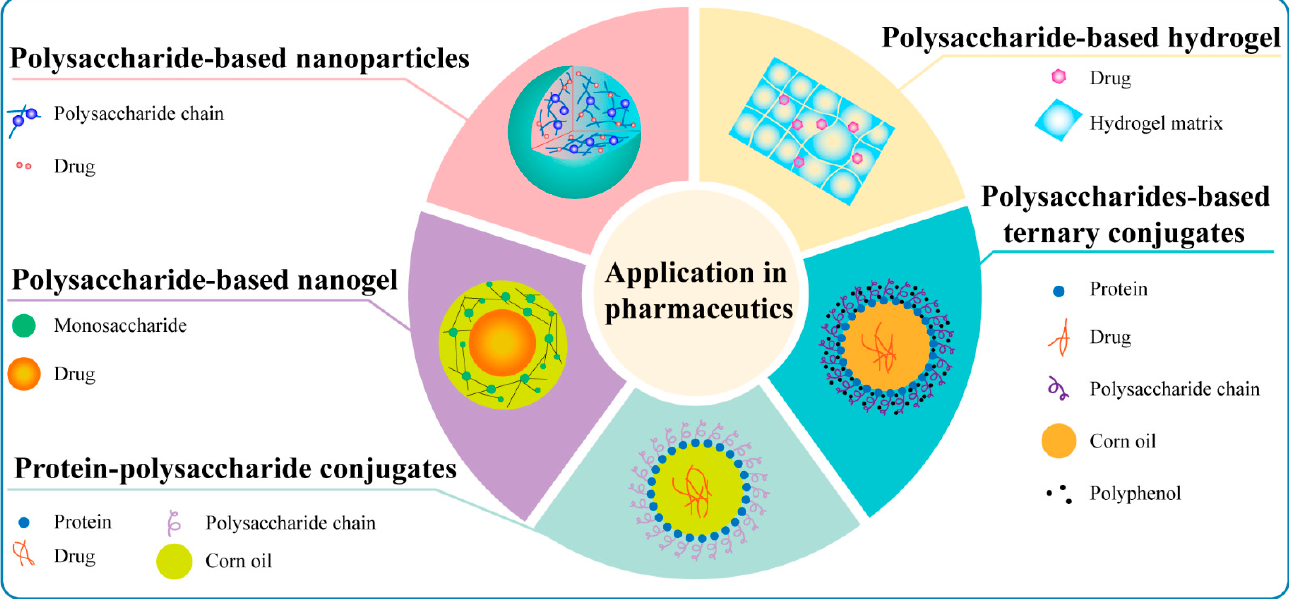
Figure 5. The application of natural polysaccharides in pharmaceutics or drug delivery.